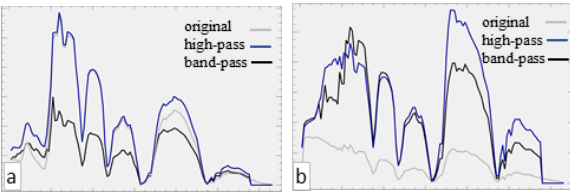
Figure 7. Quality control of fused images (Figure 6a and 6b) using spectral profile of selected pixels of (a) vegetation area and (b)